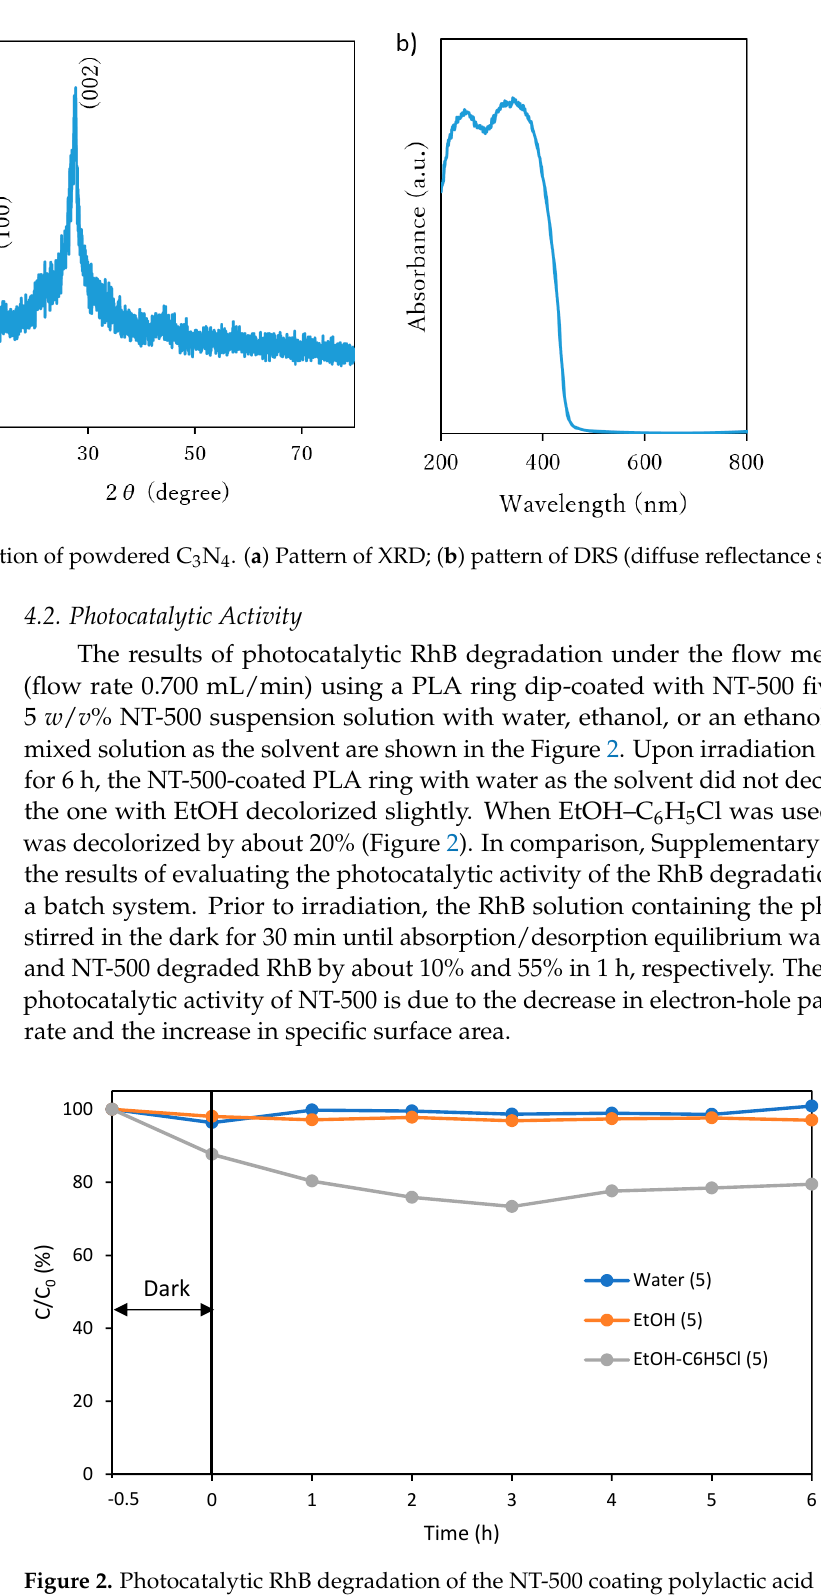
Figure 2. Photocatalytic RhB degradation of the NT-500 coating polylactic acid (PLA) prepared in different solutions for coating under flow conditions (flow rate 0.700 mL/min).